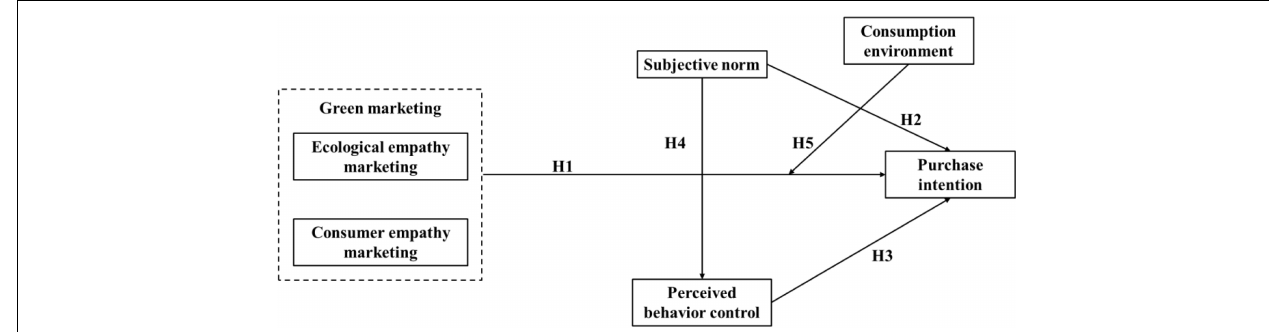
FIGURE 1 | Theoretical model